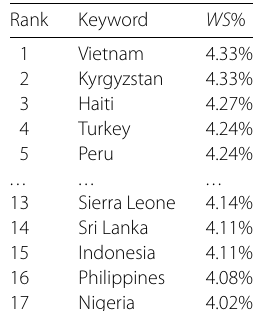
Figure 6 The relationship between co-appearances ( x -axis) and direct mentions ( y -axis) of World Bank for all